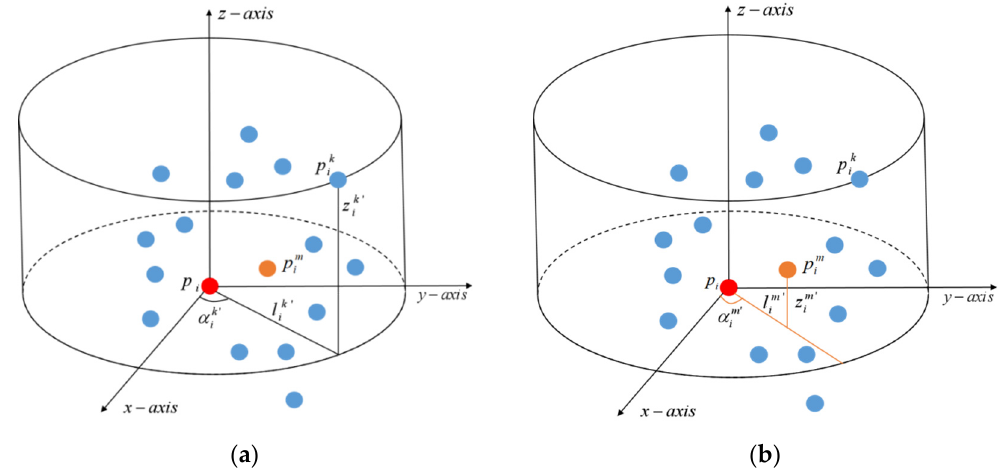
Figure 5. The conversion from the Cartesian coordinate system to the cylindrical coordinate system. ( a ) The cylindrical coordinate system spatial information between the centre point and each of its k th neighbouring points. (Red: centre point; Blue: neighbouring points; Yellow: the centre of mass). ( b ) The cylindrical coordinate system spatial information between the input point and the centre of